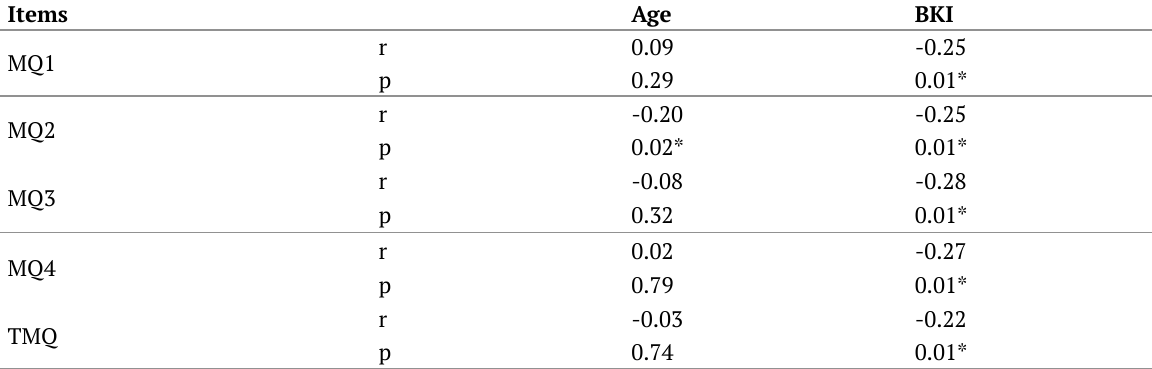
Table 5. Examining the Relationship between